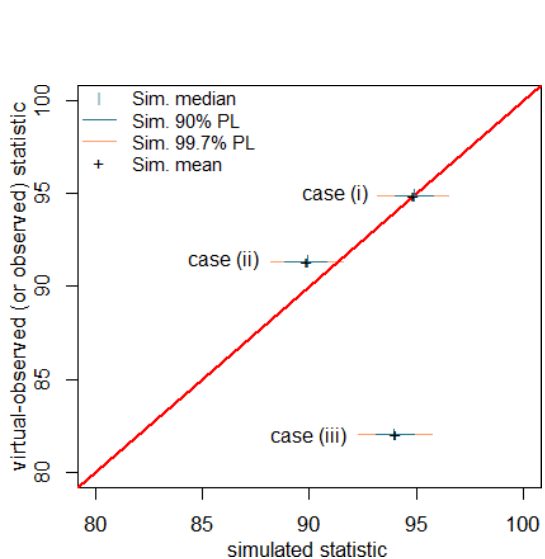
Figure 2. Virtual hydrological evaluation procedure.